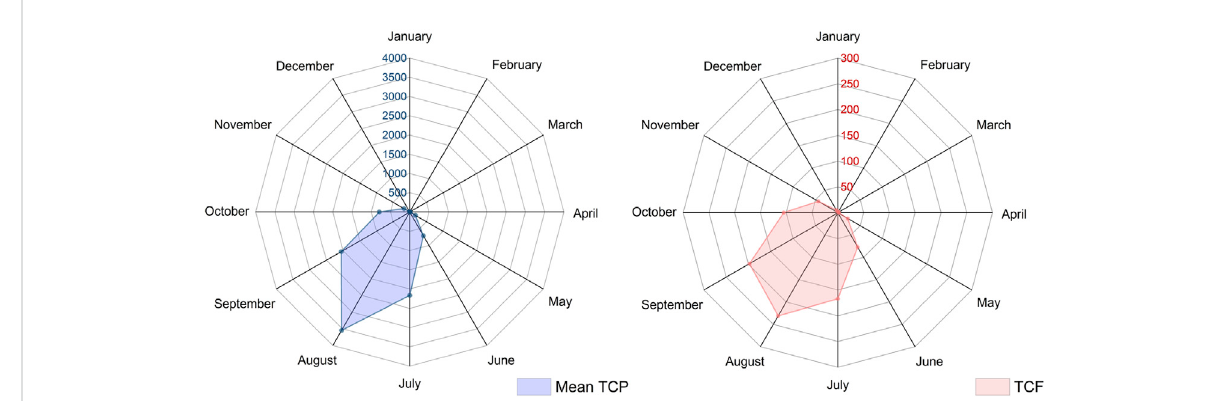
FIGURE 7 Monthly total TCP and TCF variations over China from 1959 to